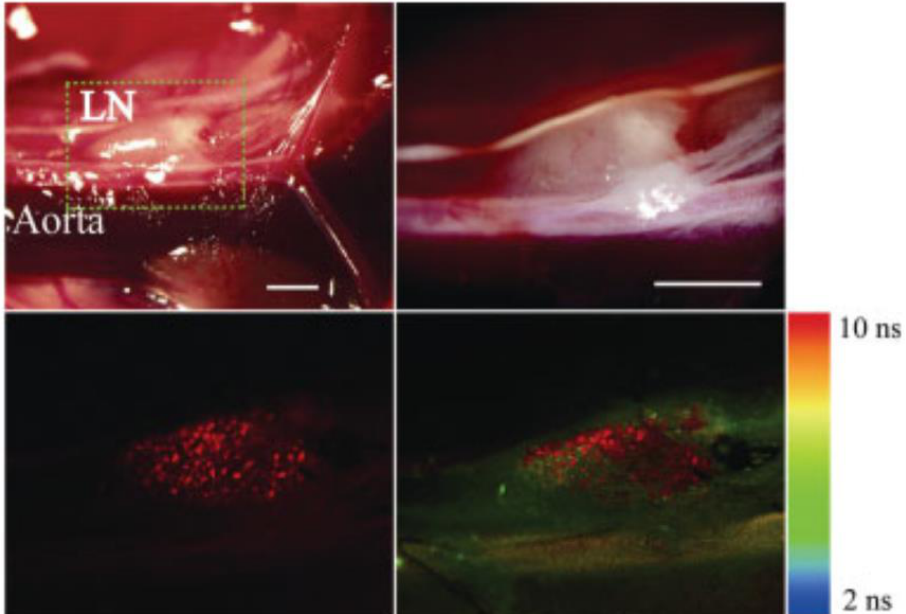
Figure 6. Fluorescence lifetime imaging (FLIM) analyses for specific detection of protoporphyrin IX (PpIX). “Reprinted/adapted with permission from Ref. [4]. 2009, John Wiley & Sons Ltd”. Results of in vivo evaluation of lymph node (LN) metastases in an orthotopic xenograft murine model of human colorectal HT-29 carcinoma cells after treatment with 5-aminolevulinic acid (5-ALA) are shown. 5-ALA (250 mg/kg body weight) was injected in the tail vein before the experiment. A portion of the abdominal cavity, enclosed with a dashed line (upper left: white-light image), was examined using FLIM microscopy. Also depicted are an extended figure of the identical field (upper right: white-light image), a confocal fluorescence intensity image (lower left; excitation: 405 nm, emission: 600 – 660 nm), and the corresponding FLIM image (lower right; excitation: 405 nm, emission: >420 nm). Scale bars: 1 mm.